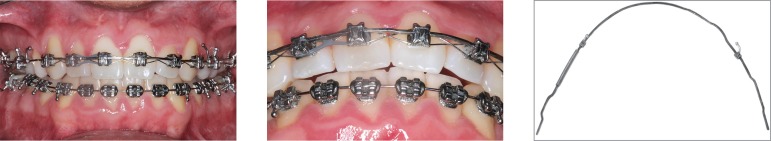
Final leveling phase with individualized bends for treatment finishing: buccal
steps on teeth #16, 26, 12 and 13; and "Z" bend on tooth #21.